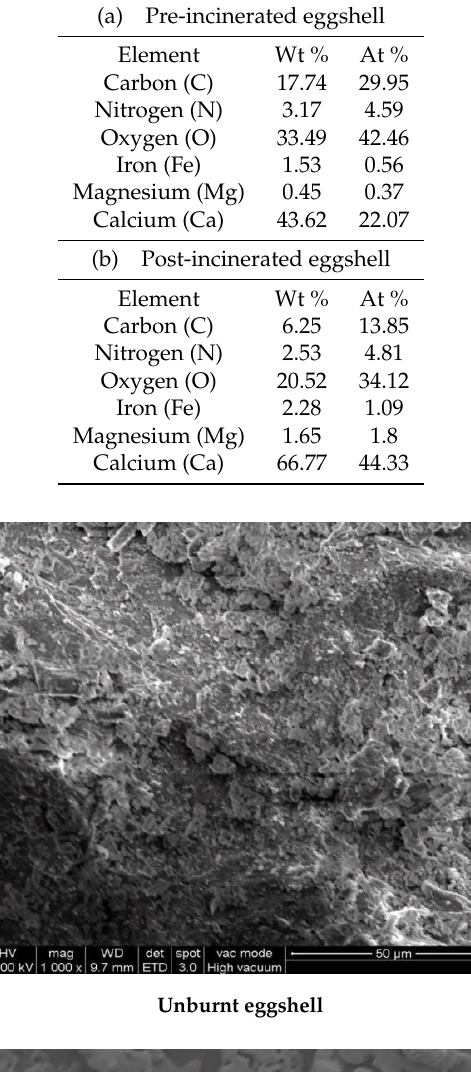
Table 1. Detailed composition of (a) pre-and (b) post-incinerated eggshell.